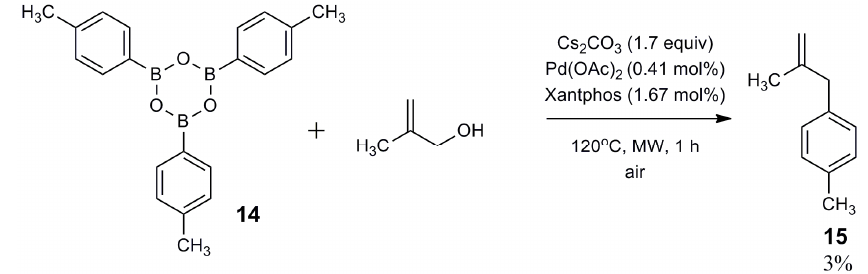
Figure 4. Synthesis of compound 15 from boroxine 14 .